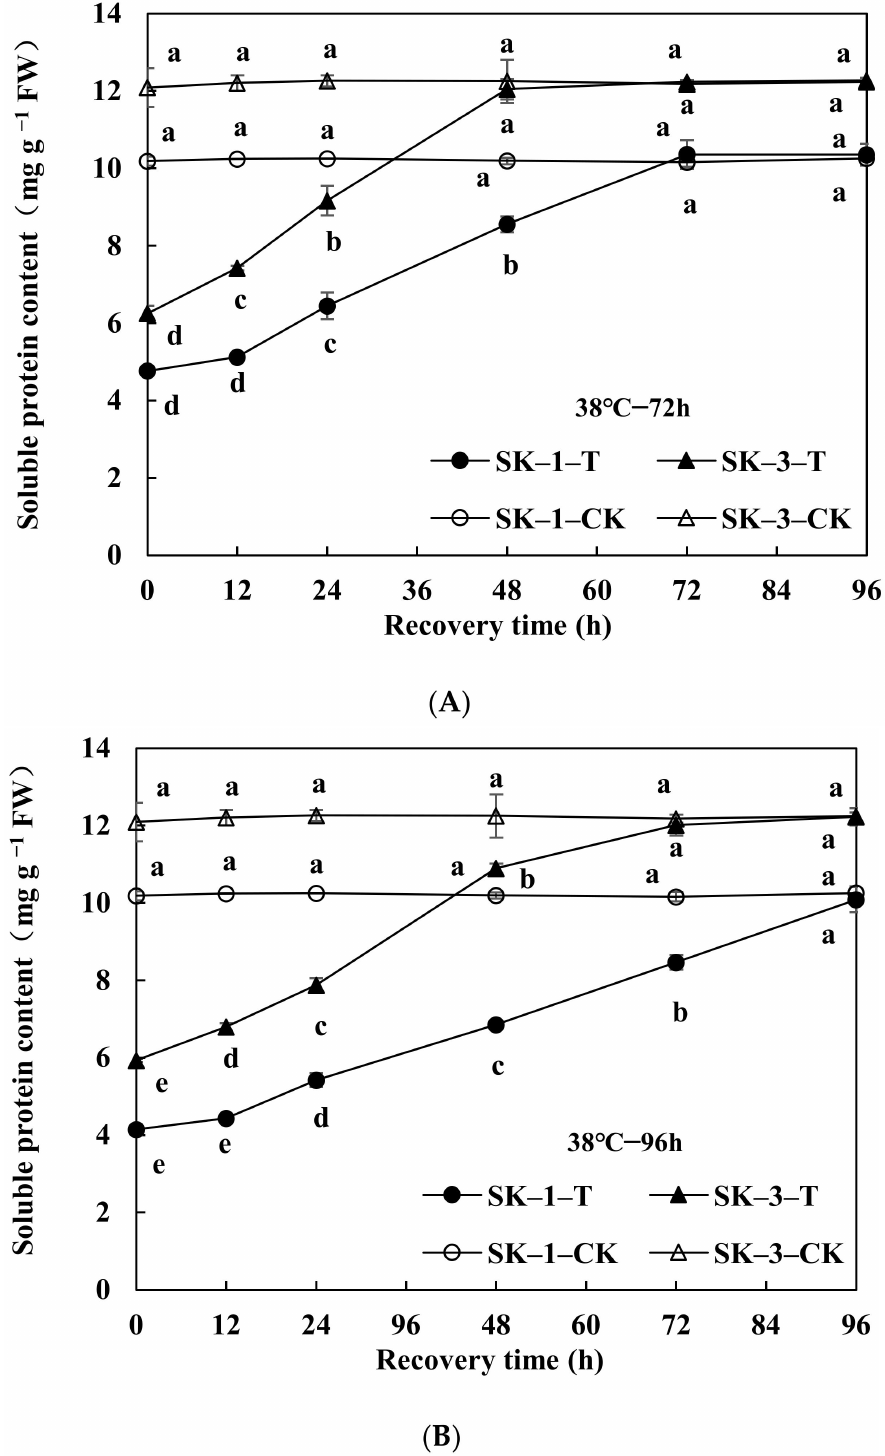
Figure 2. Changes in soluble protein content in squares of Bt cotton after 72 h ( A ) and 96 h ( B ) high- temperature stress termination. Soluble protein content at the recovery time with different lowercase letters is significantly different from the control at p < 0.05 under the same high-temperature stress duration for the same cultivar. T—treatments for 72 h ( A ) and 96 h ( B );